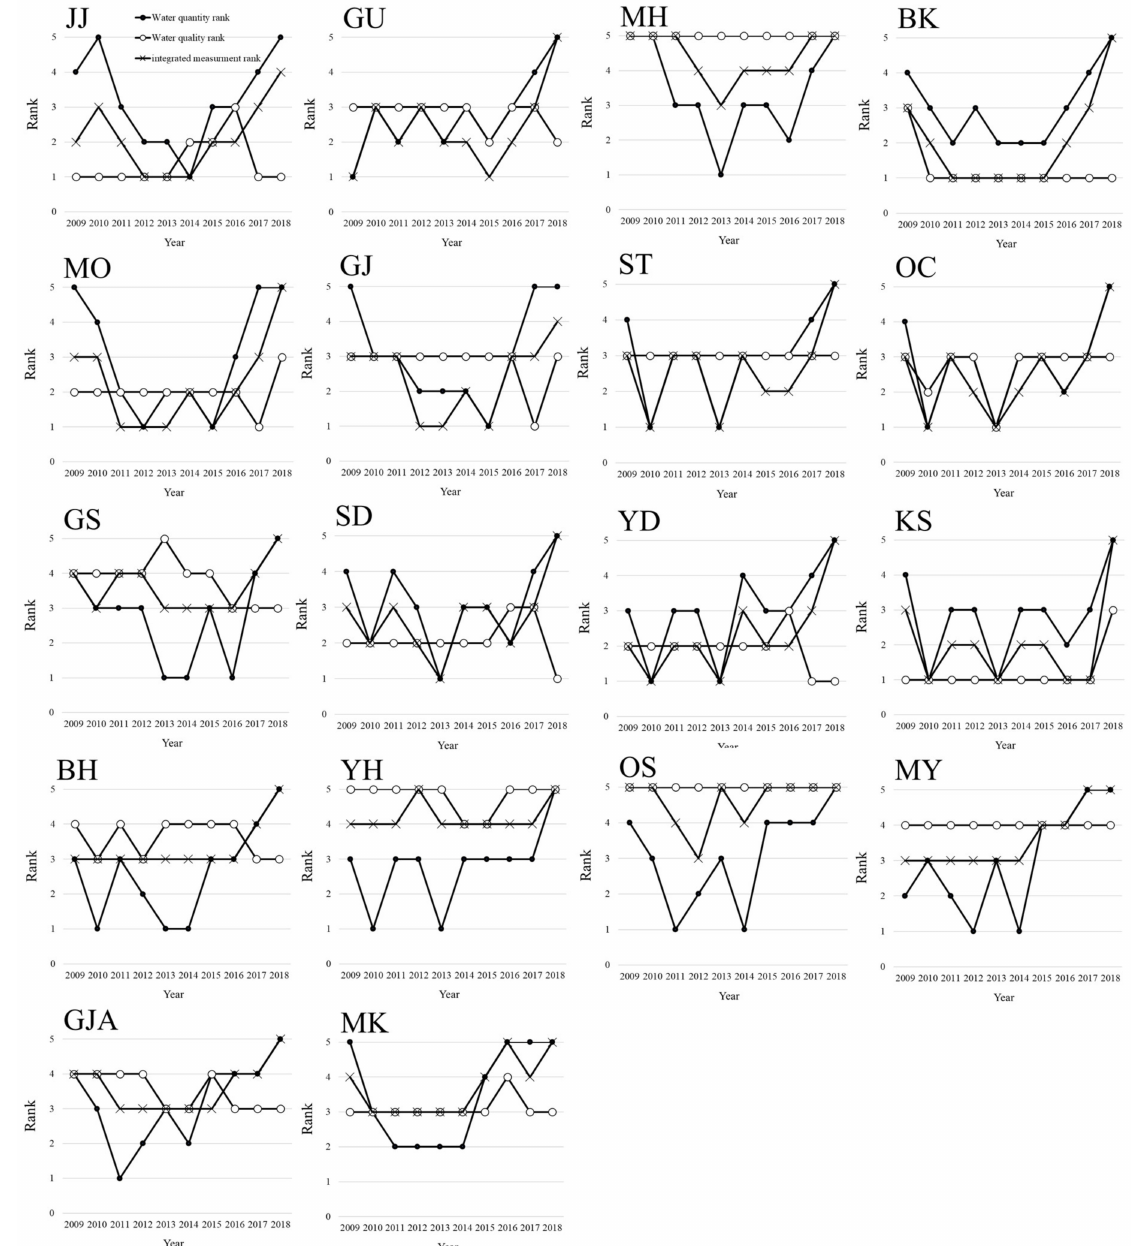
Figure 9. Variations in annual rank during the study